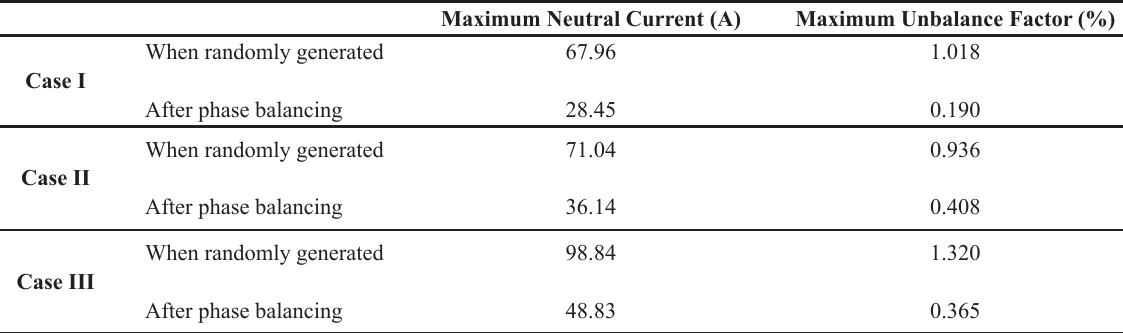
Table 2: Comparison of maximum neutral current and voltage unbalance factor obtained by randomly generating and after phase